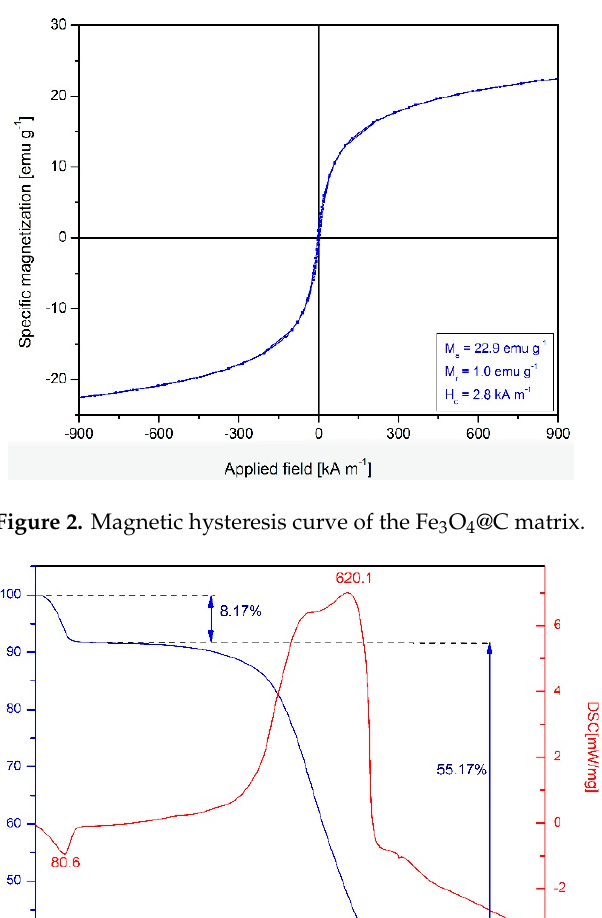
Figure 3. TG-DSC curves of the Fe 3 O 4 @C matrix.